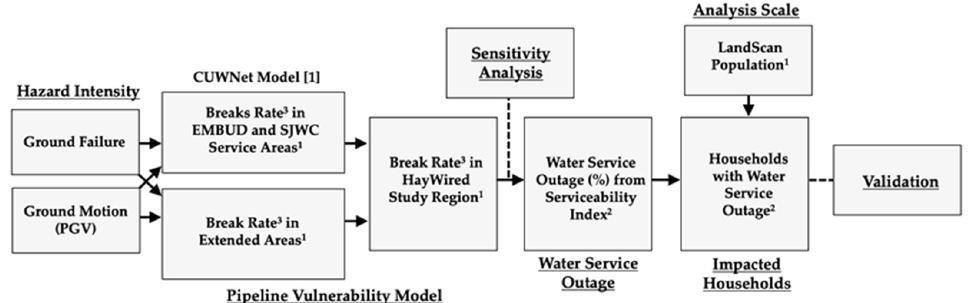
Figure 4. Simplified method to estimate water pipeline break rates and water service outage. 1 Calculated at the ~90 m 2 (three-arcsecond) grid cell in the case study, based on LandScan population data. 2 Calculated at the ~250 m 2 (nine-arcsecond) grid cell in the case study, based on the sensitivity analysis. 3 Average breaks per 1 km of pipe.